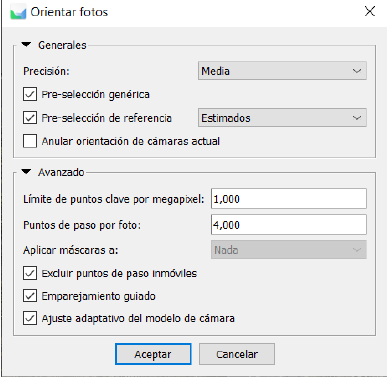
Figure 8. Photo Orientation Parameters of the topography.